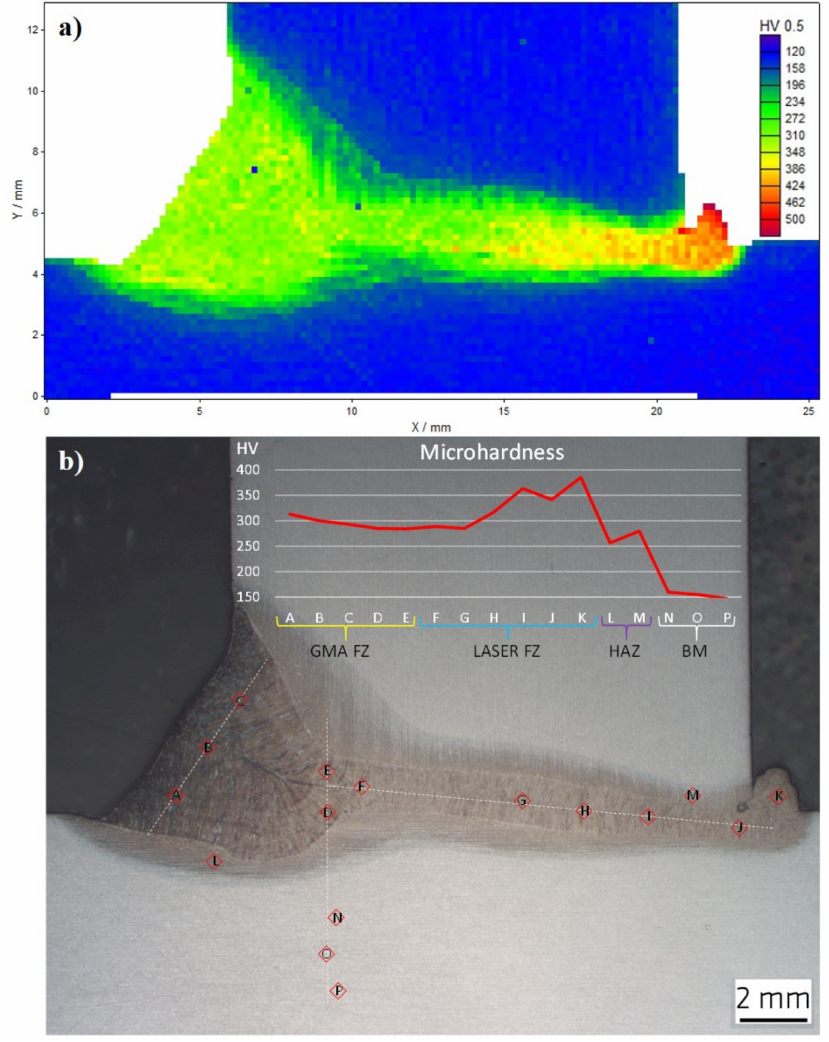
Figure 12. ( a ) Microhardness map of the F specimen on one side weld; ( b ) hardness variations within the T-joint hybrid weld